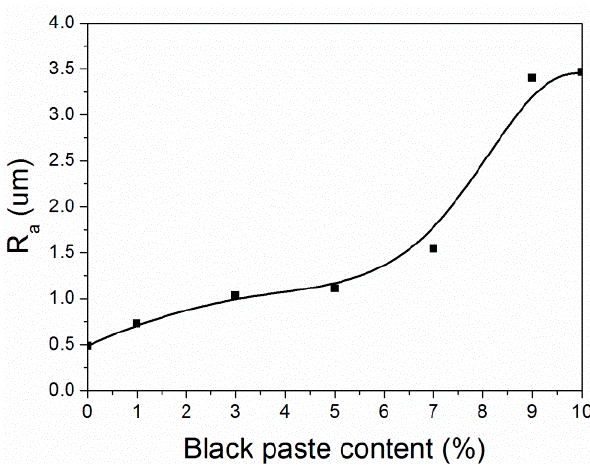
Figure 8. E ff ect of black paste content on the roughness of the coatings. Figure 8. Effect of black paste content on the roughness of the coatings.